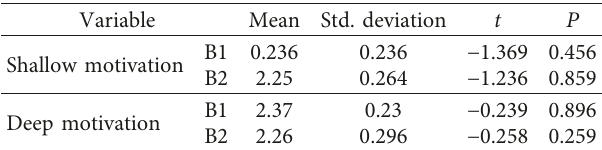
Table 10: Analysis results of learning motivation and